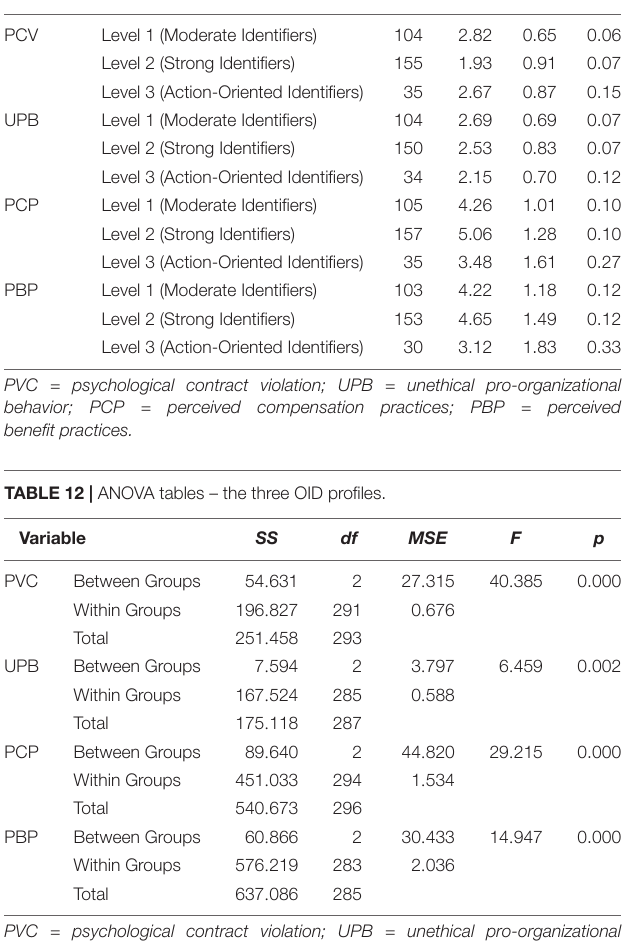
TABLE 11 | Organizational Variable Mean Differences across the Three OID Profiles. Variable